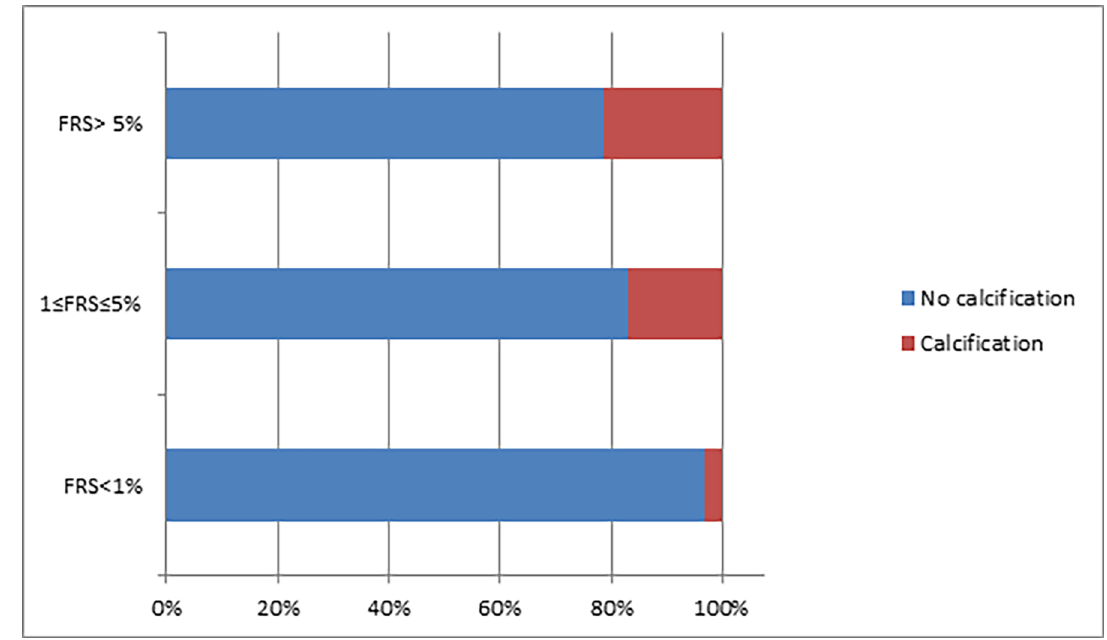
Fig 1. Calcification percentage by cardiovascular risk category. FRS = Framingham risk